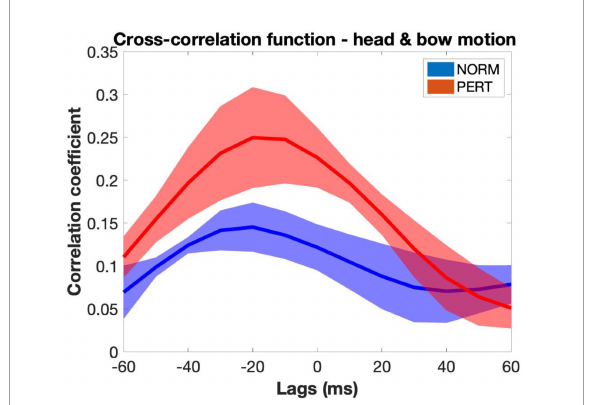
FIGURE2 Average cross-correlation functions between head and bow motion across takes and violinists in the NORM and PERT conditions (shaded areas represent standard errors of the mean). Correlation coefficients were higher in the PERT condition than in the NORM condition, suggesting that head and bow were more strongly coupled during PERT. In both conditions, average functions peak at negative lags, indicating that head movements slightly preceded bow movements. Note that this figure represents all cross-correlation functions computed for each 1-s window averaged across participants and then across takes. The amplitude of the peaks of these average functions and the lag at which they are observed can thus differ from the values of the indices obtained by extracting only the peak correlation value and the associated lag in each 1-s